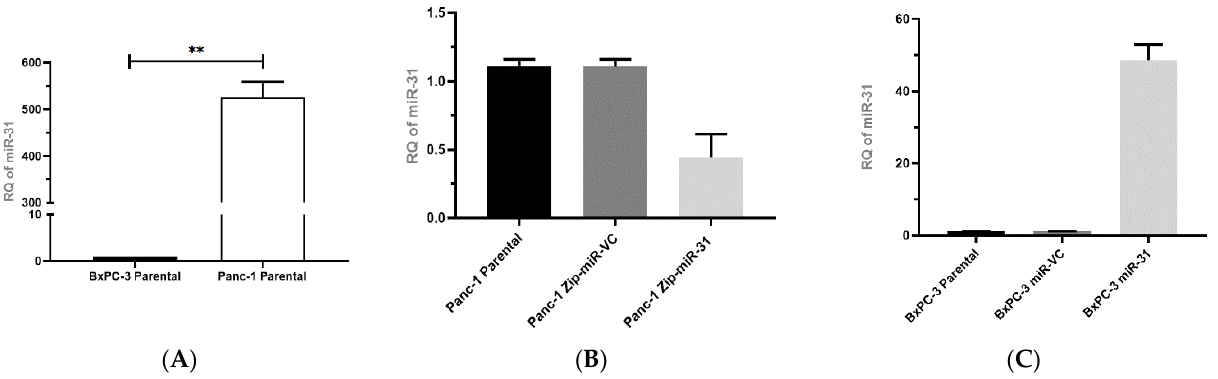
Figure 1. Establishing and confirming miR-31 stable transfection in PDAC cell lines. ( A ) qPCR evaluating the relative level of miR-31 expression between BxPC-3 and Panc-1 cell lines. Endogenous miR-31 were significantly higher in Panc-1 cells compared to BxPC-3 cells (** p = 0.0038). Data are expressed as the mean ± SEM and analyzed by a one-sample t -test ( n = 3). ( B ) qPCR evaluating the relative levels of miR-31 expression between Panc-1 parental, Zip-miR-VC, and Zip-miR-31 cell lines ( n = 3). ( C ) RT-qPCR evaluating the relative levels of miR-31 expression between BxPC-3 Parental, miR-VC, and miR-31 cell lines ( n = 3).